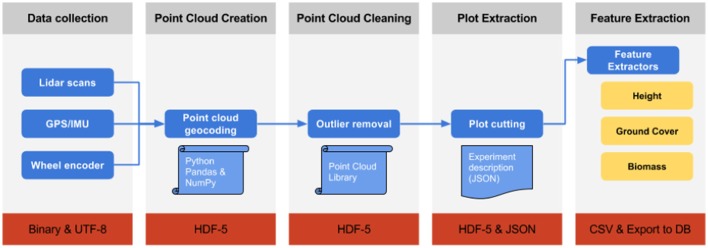
Schematic of the Phenomobile Lite LiDAR data processing workflow, whereby each box represents the following steps (from left to right). Data collection: Raw data collection with the Phenomobile Lite touch screen computer. Point Cloud Creation: the collected LiDAR data is converted into X,Y,Z coordinates. Point Cloud Cleaning: LiDAR data is cleaned and outlier points, resulting from partial returns. Plot Extraction: LiDAR data is segmented into experimental plots by the user, through a web interface (Figure 3). Feature Extraction: Trait data are extracted from the LiDAR data for each experimental plot. The outgoing data file format for each step is indicated in the respective red rectangle.